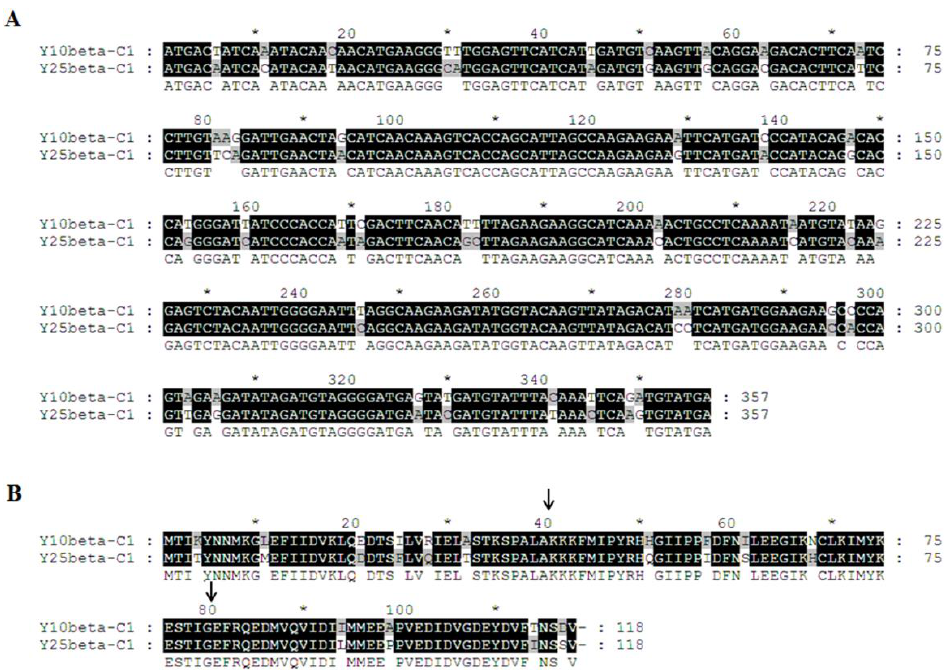
Figure 6. Alignment of βC1 nucleotide sequence ( A ) and predicted βC1 amino acid sequence ( B ) from TYLCCNB-Y10 and TYLCCNB-Y25. Arrowheads indicate the split sites.